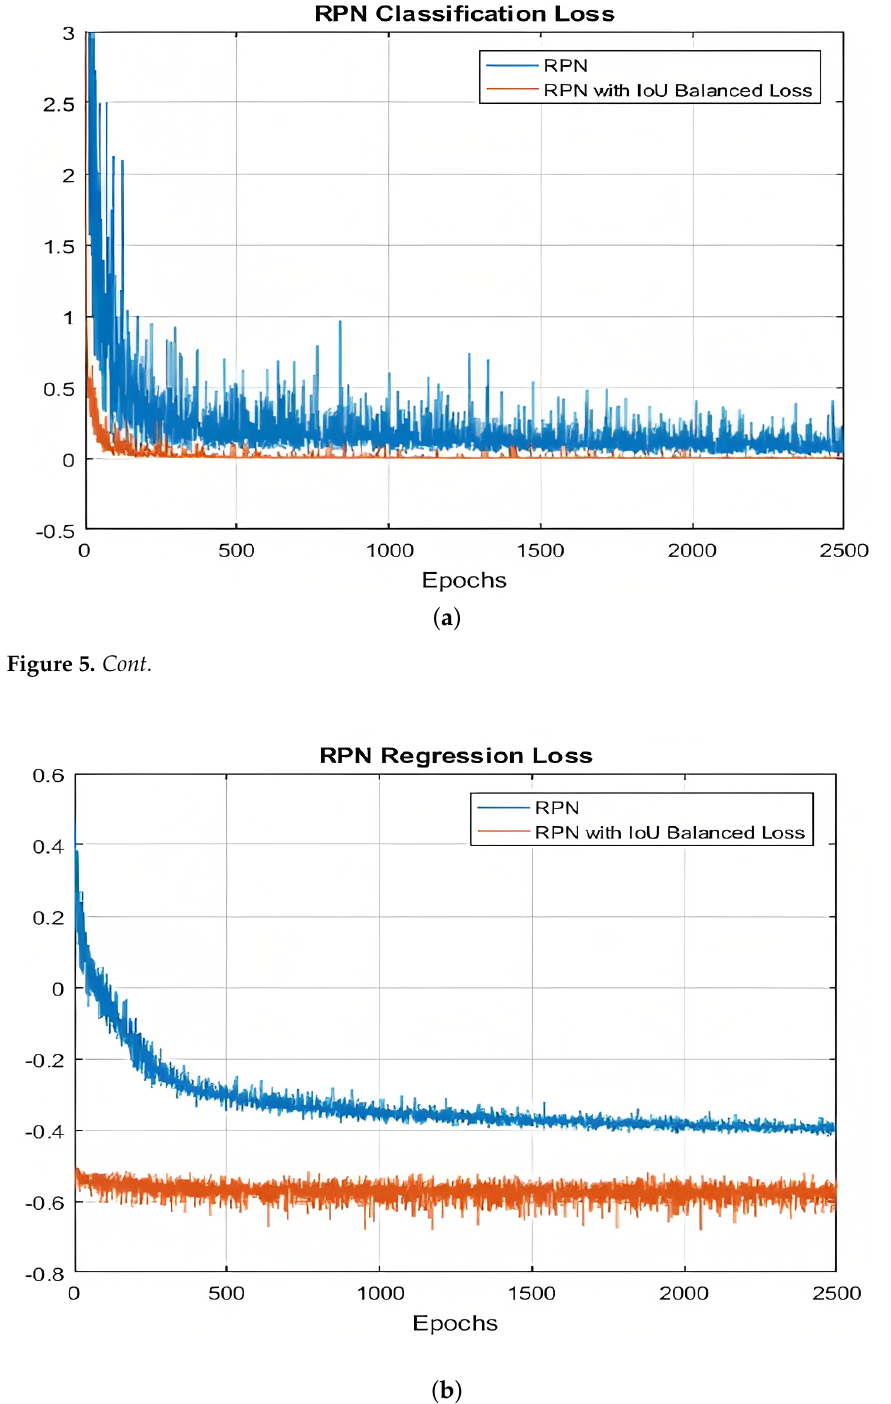
Figure 5. Loss function curves: ( a ) loss function classification: the typical loss function and the IoU -balanced loss, ( b ) loss function localization: the typical loss function and the IoU -balanced loss for